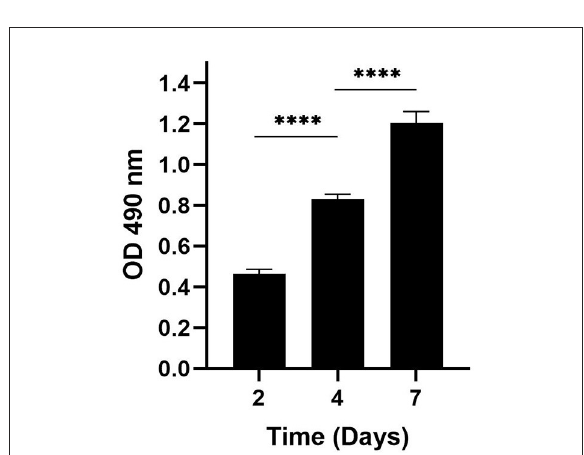
FIGURE2 Measurement of proliferation rate of HFFs. MTS assay was used to demonstrate the proliferation of HFFs in presence of 100%